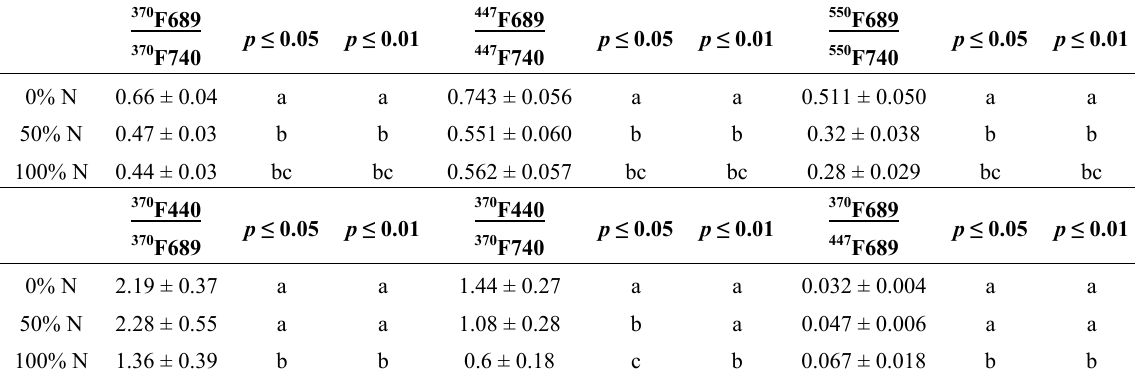
Table 2. Fluorescence ratios of barley leaves ( Hordeum vulgare L.) grown under 0%, 50%, and 100% nitrogen supply (N). The underlying images were excited with UV-A (370 nm), blue (447 nm) or green light (550 nm), and detected at three bands (440, 689, and 740 nm). The average fluorescence values were calculated from the middle part of the images (integrated values of all the pixels). The values (± SD) are the result of eight barley leaves for each N-treatment. Mean values in the same column with different letters are significantly different (one-way ANOVA, Scheffé